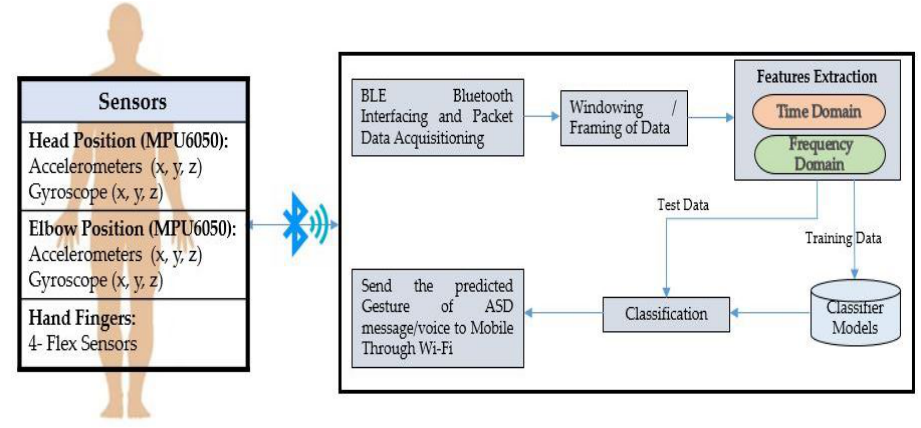
Figure 1. The proposed architecture for body-worn sensors-based IoT platform for ASD children’s gestures recognition.